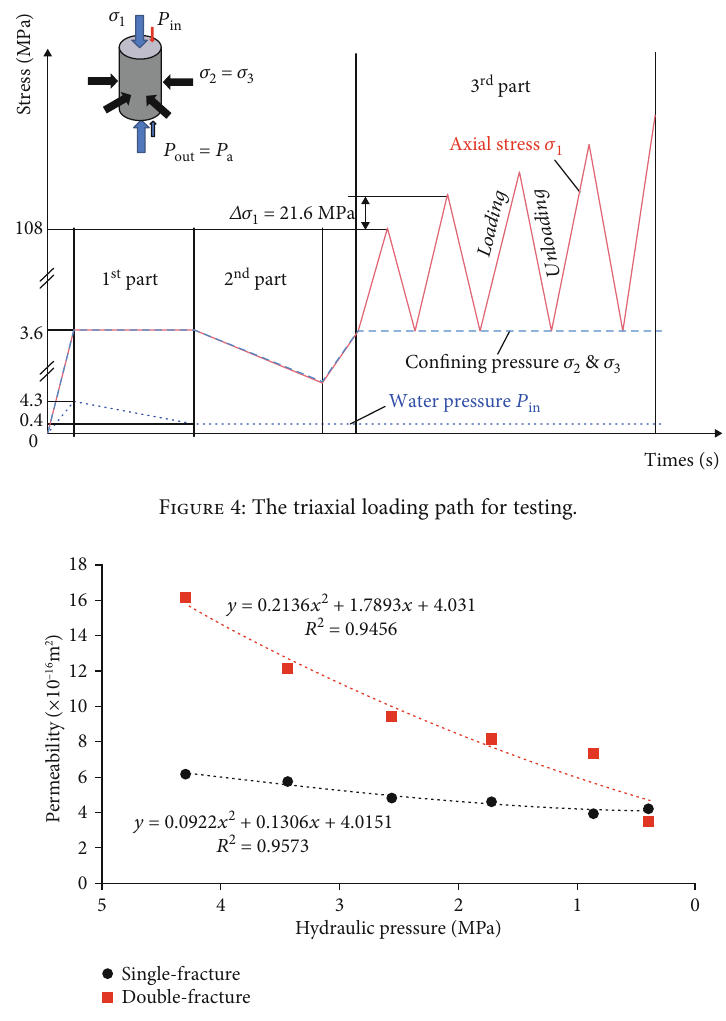
Figure 5: Permeability evolution of fractured sandstones under di ff erent hydraulic